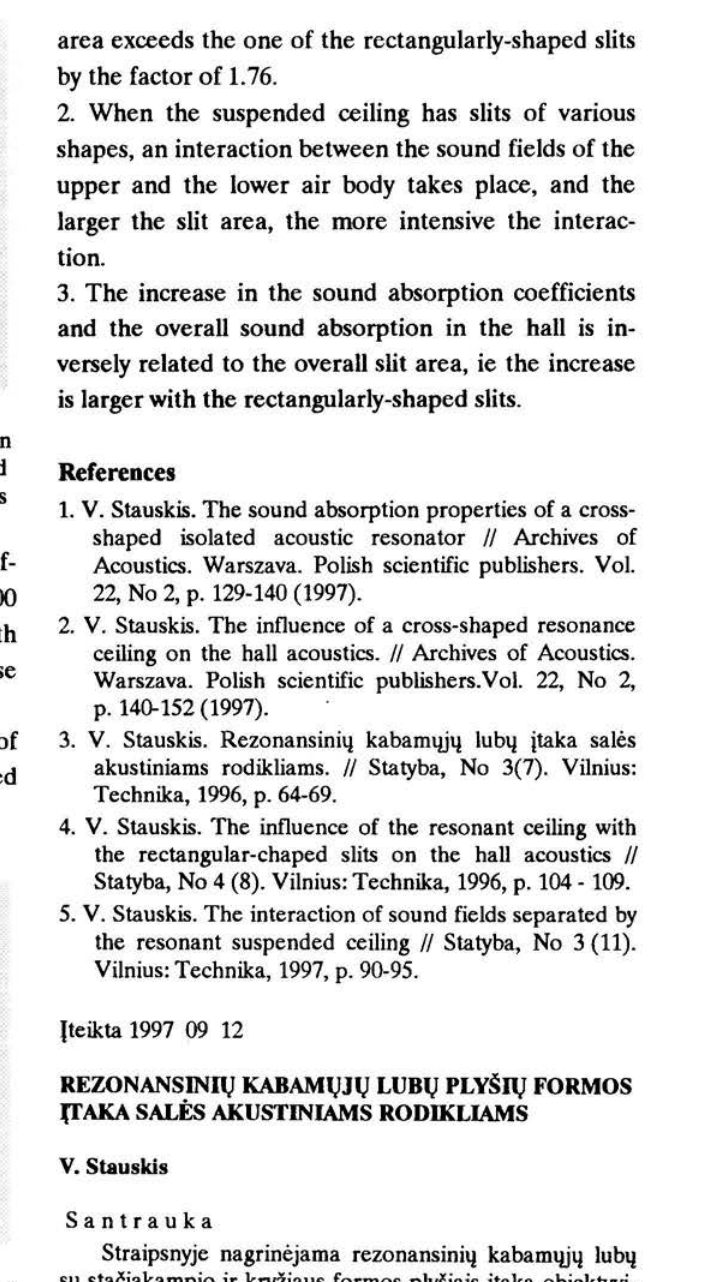
Fig 10. The dependence of the acoustic centre of gravity on the form of the slits in the suspended ceiling. 1 - without suspended ceiling; 2- cross-shaped slits; 3 - rectangularly shaped slits The acoustic centre of gravity is increased by the suspended ceiling beginning with the frequencies ex ceeding 200 Hz, whereas the influence of the change in the shape of the ceiling and the overall slit area is